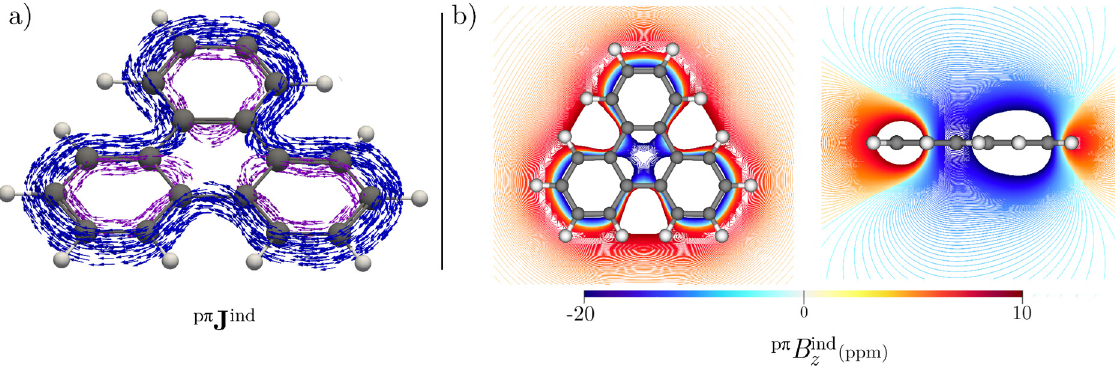
Figure 3. ( a ) p π J ind vector maps showing the diatropic peripheral ring current (in blue) and the local diatropic currents (in purple) of [4]starphene. ( b ) Isolines of p π B ind z calculated in the transverse plane (left) and the molecular plane (right) of [4]starphene (scale conventions as in Figure 2). Table 1. Ring-current strengths (in nA/T) of starphenes divided into their diatropic and